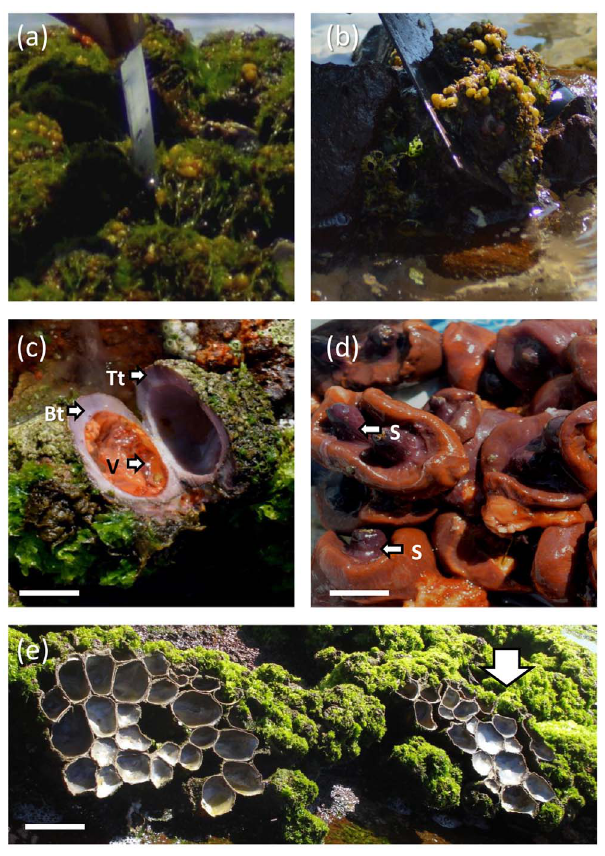
Figure 2. Pyurapraeputialis. Photographic record of two extracting tools: (a) knife. (b) hand saw-blade. After the tough tunic is cut the top tunic is opened by hand to remove the edible parts or siphons (S). (c). The basal tunic (Bt) including the remains of the internal visceral tissues (V) and the top tunic (Tt) still connected with the basal tunic remains attached to the rocky substrate. (d) Only the upper parts of the soft tissues, mainly the siphons (S) are retrieved for consumption. (e) After a few hours local birds, fishes and wave action will remove the flesh and only the remains of contiguous tunics are observed. The green coloration (white arrow) on top of the matrices are the green algae Ulva spp. that grow on the siphonal zone of the tunicates. The scale bars =5 cm (c), =2 cm (d) and =10 cm (e).